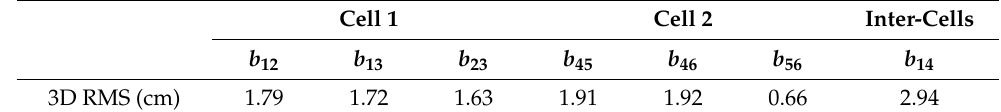
Table 3. 3D RMS positioning errors of the baselines in the two cells and two master agents using a one-to-one and antenna-array RTK of the proposed framework.